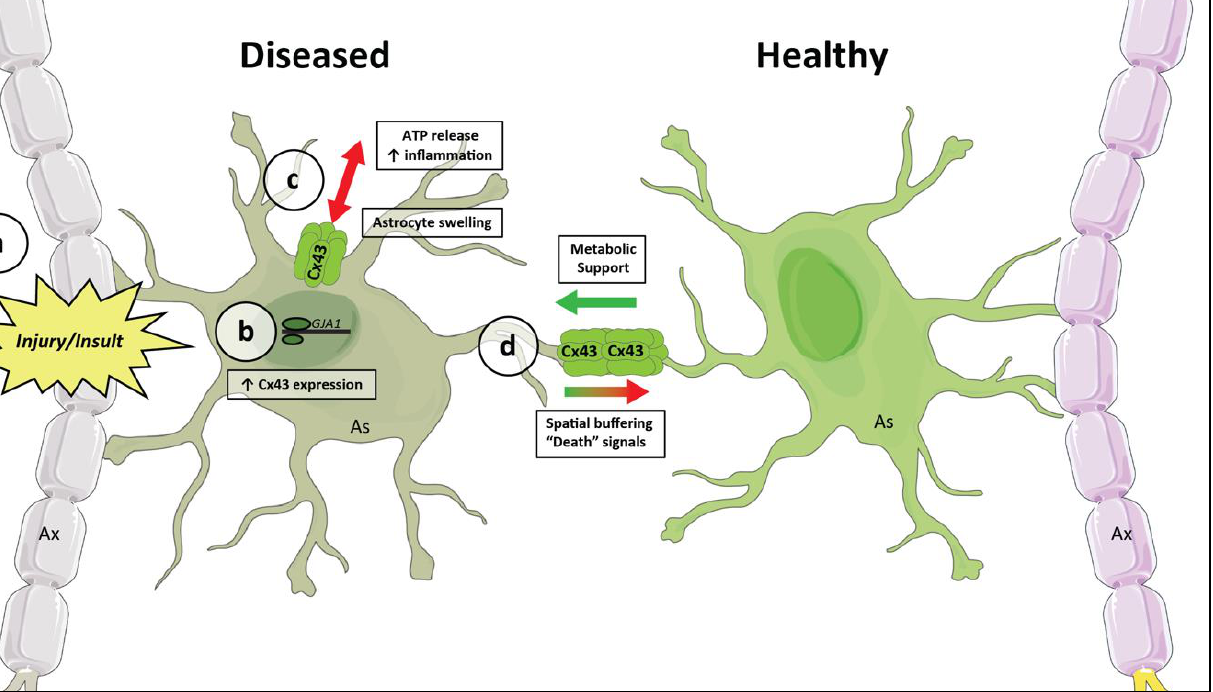
Figure 2. A working model of the role of Cx43 in neurologic disease. A pathologic insult to neural tissue ( a ) causes an increased expression of Cx43 ( b ). Cx43 connexons are assembled and transported to the cell membrane, increasing the number of unopposed hemichannels ( c ). This allows for the extracellular release of adenosine triphosphate (ATP), causing increased inflammation and microglial activation. Open Cx43 hemichannels also cause cellular swelling. Increased degradation and post-translational modifications, as well as physical swelling of the cell, cause a decrease in Cx43 gap junctional coupling ( d ). Consequently, there is less available metabolic support from distant astrocytic glycogen stores. There is also a decreased ability to spread out the effect of local increases in extracellular glutamate and potassium through spatial buffering. However, this may also be protective by limiting the spread of calcium waves and other “death signals” to nearby healthy tissue. Cells on the left represent a generic region of CNS pathology, while healthy brain tissue is on the right. Ax, axon; As, astrocyte; and Cx43, connexin-43.